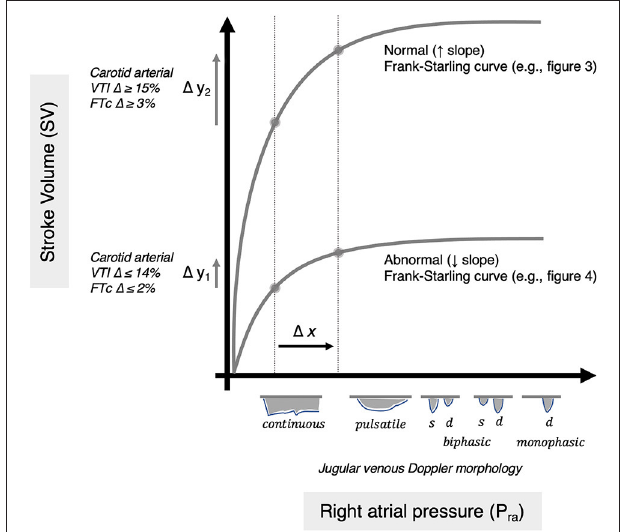
FIGURE 1 | Depiction of normal and abnormal Frank–Starling relationships. The abscissa is P ra or right atrial pressure as classically measured (e.g., by a pulmonary artery catheter). The venous Doppler morphology is depicted as a surrogate for P ra (2, 3). The ordinate is stroke volume as classically measured (e.g., by a pulmonary artery catheter). The change in carotid arterial Doppler is shown as a surrogate for changing stroke volume ( 4, 5). Two theoretical curves are depicted with equal change in P ra , for example from a passive leg raise (arrow 1 x ). Two potential responses in SV are observed: (1) abnormal, unhealthy ( 1 y 1 ) and (2) normal, healthy ( 1 y 2 ) such that two semiquantitative slopes ( 1 y / 1 x ) are inferred.